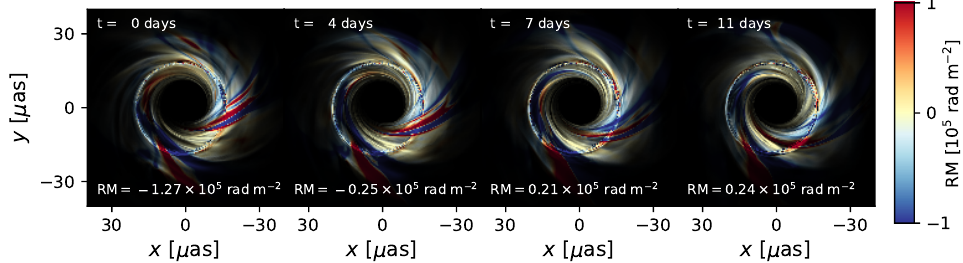
Figure 4. Rotation measure map of a MAD simulation of M87* adapted from Figure 13 of Ricarte et al. [44]. Both positive and negative RM regions are simultaneously present, reflecting flips in the line-of-sight magnetic field direction due to turbulence in the accretion flow. The motion of these structures produces a time variable spatially unresolved RM, written at the bottom of each